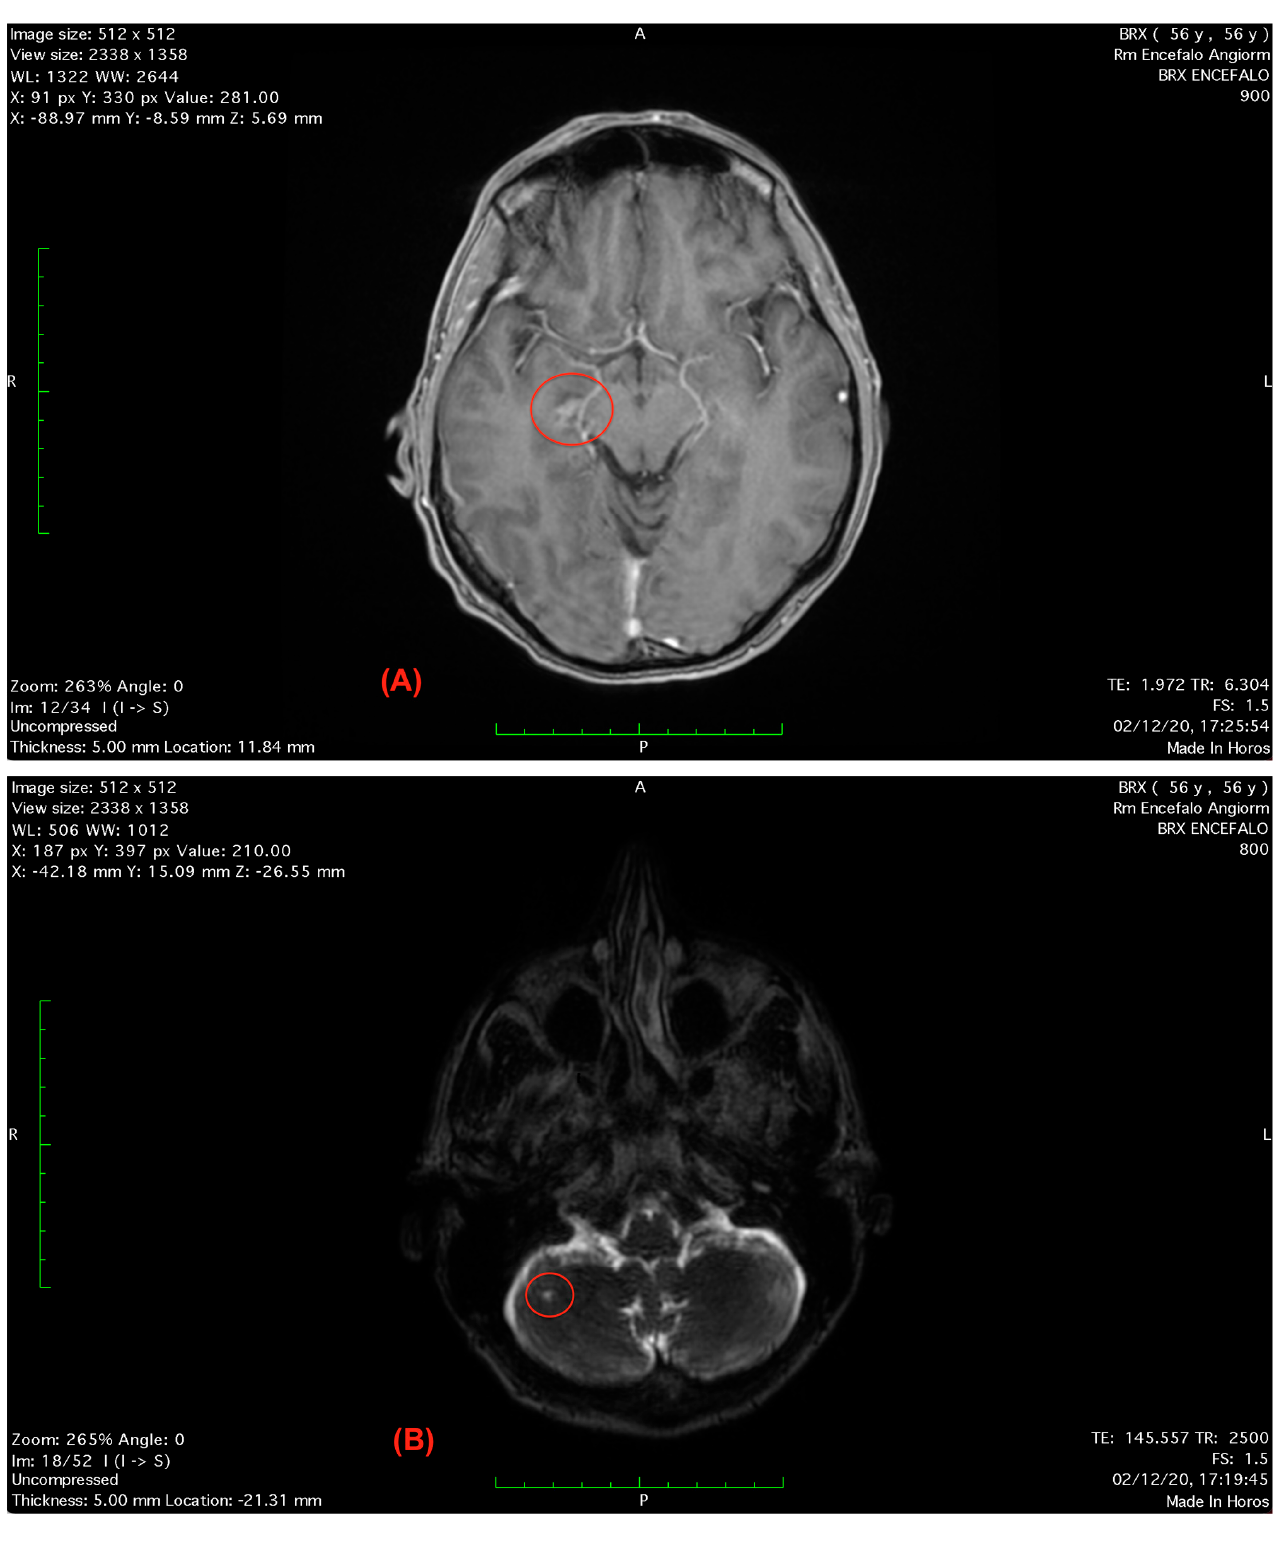
Figure 2. ( A ) Axial T1-weighted FLAIR scan showing a small hyper-intense areola in correspondence to the lower right midbrain’s colliculus. ( B ) Axial T2-weighted brain magnetic resonance imaging scan showing the small hyper-intense areola in the right cerebellar